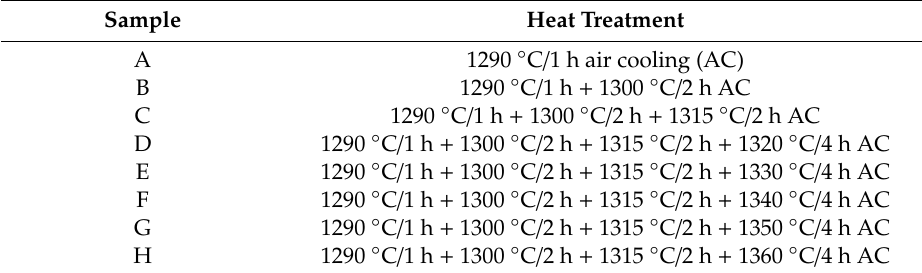
Table 2. Stepwise solid solution heat treatment procedures, as designed in this study.